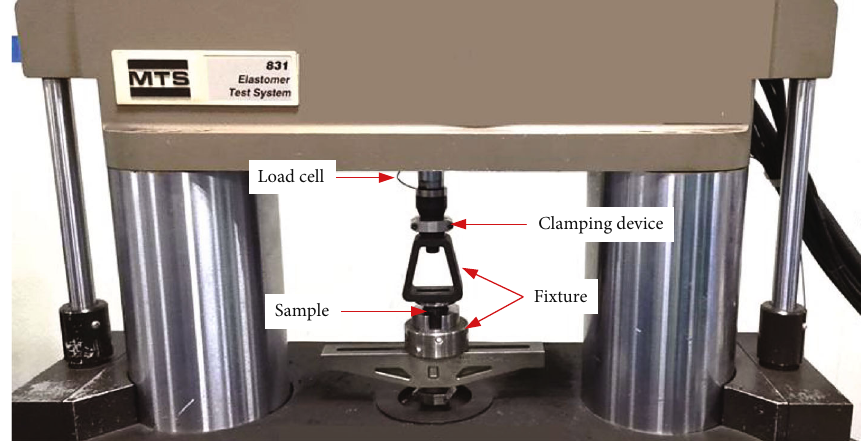
Figure 9: Test rig of the static sti ff ness and the dynamic sti ff ness. , C , and D . 10 01 1